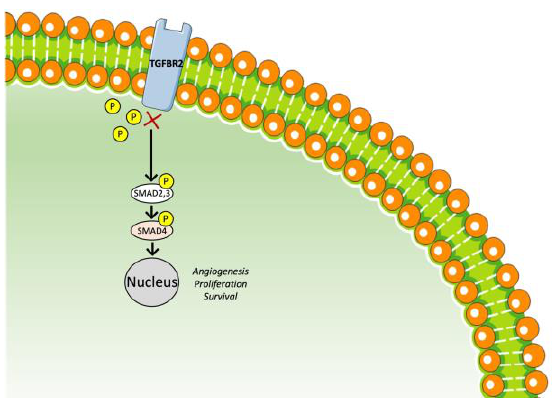
Figure 5. Mechanism of action of galunisertib for the treatment of HCC.